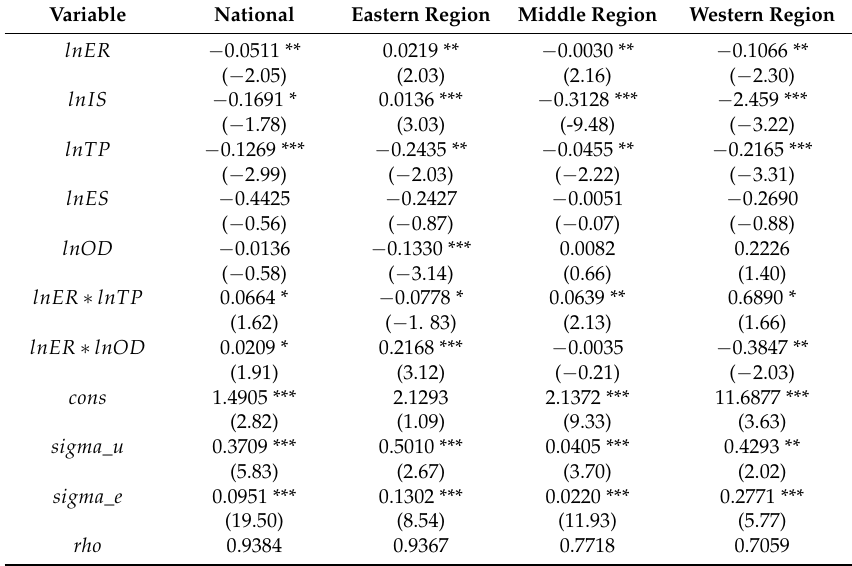
Table 5. Regression results of the Tobit